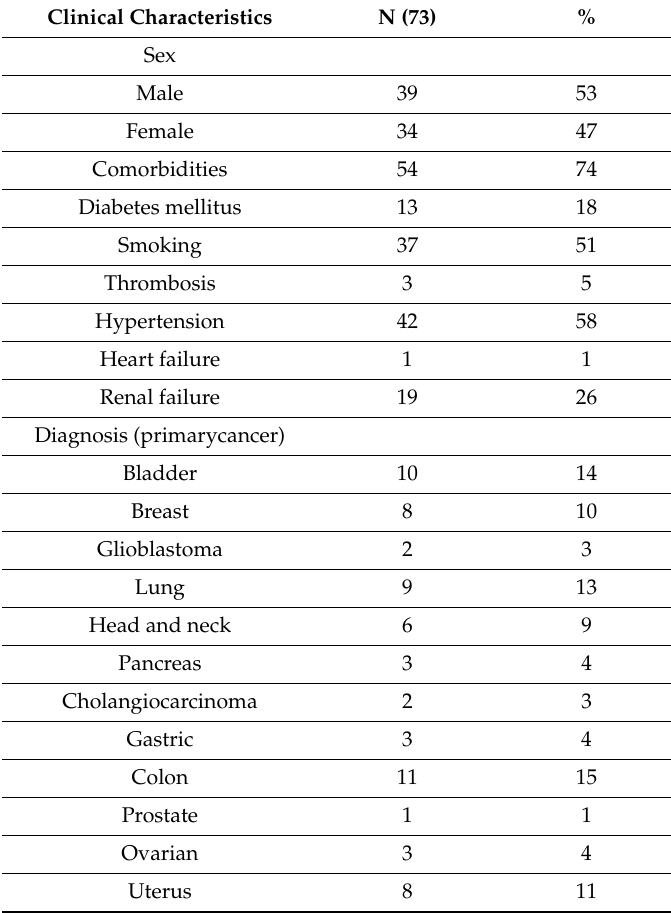
Table 1. Patients’ clinical